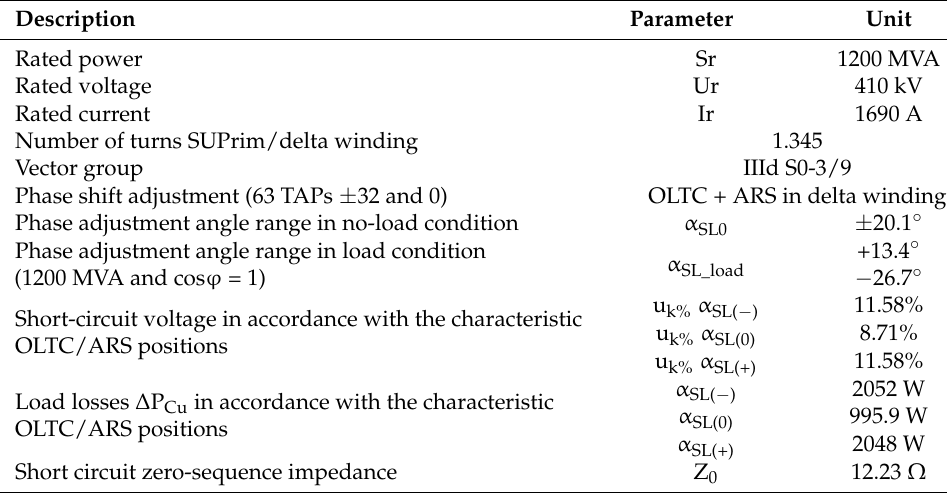
Table 1. Rated data of the modelled PST [3].